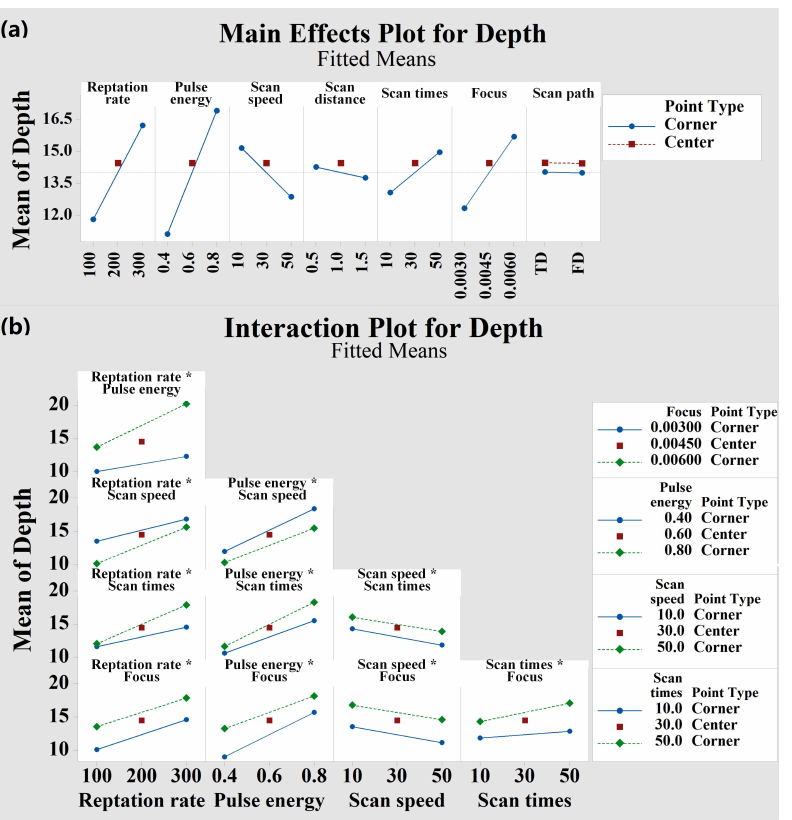
Figure 5. ( a ) Main effect plot of factors affecting the response variable depth. ( b ) Interaction plot of factors affecting the response variable depth.